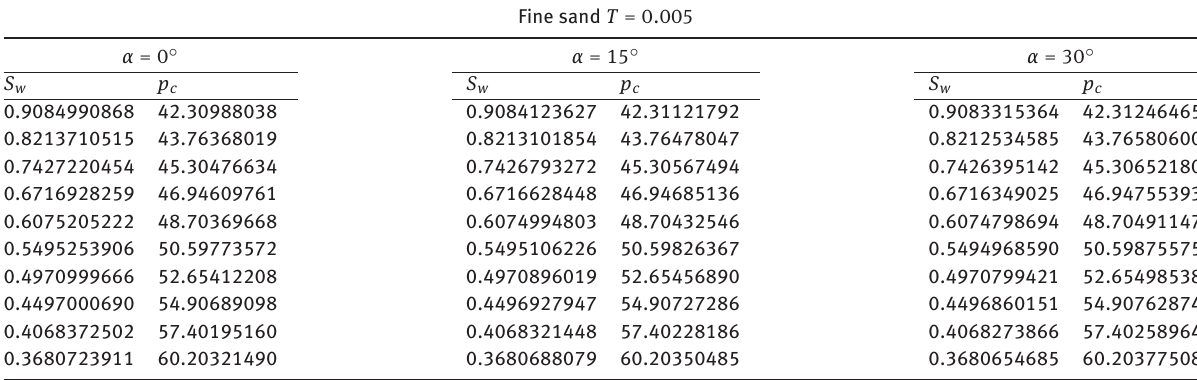
Fine sand T = 0.005